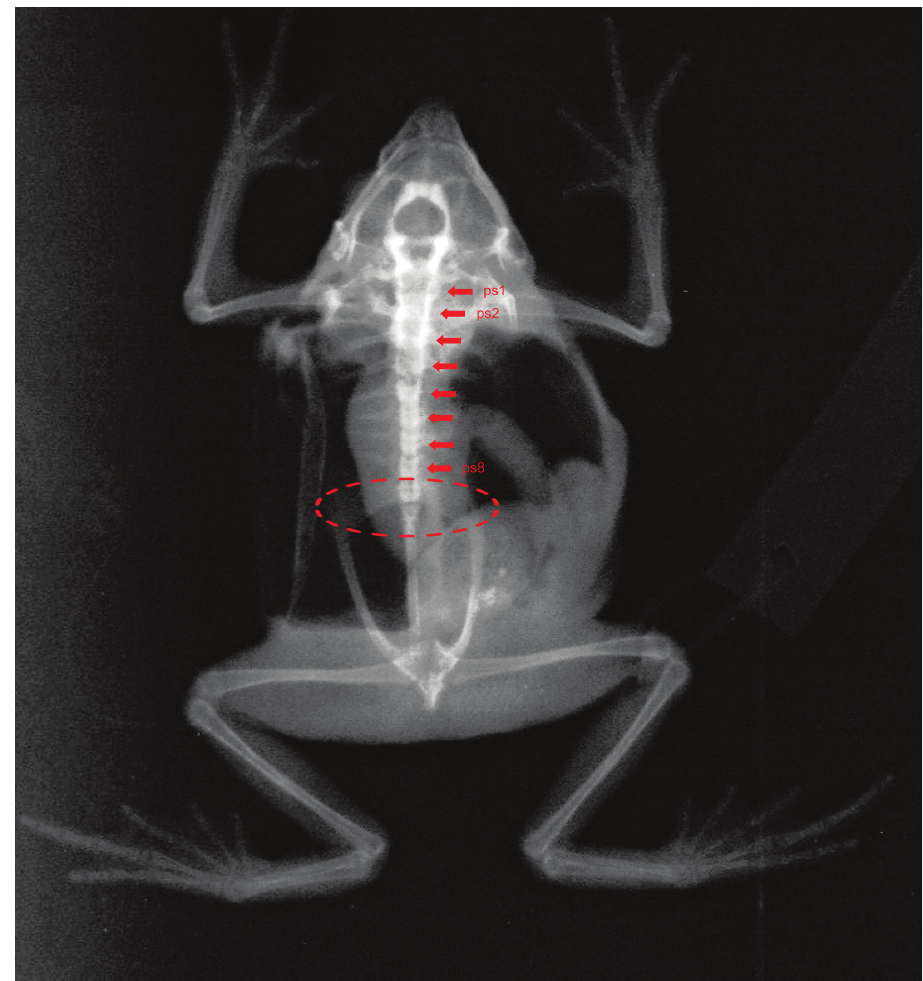
Figure 9. X-ray of the paratye Rhinella lilyrodriguezae sp. n. MUSM 32206. Photos by J. C. Cusi.